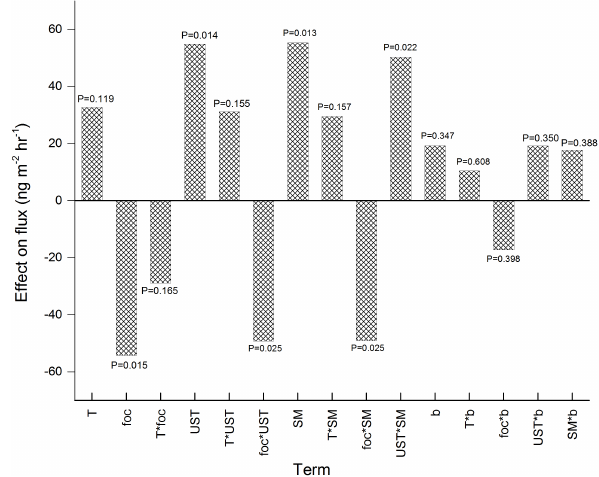
Figure 6. Sensitivity analysis based on the 2 5 factorial design for bare lands after prescreening model variables shown in Table 3 to isolate the significant factors. T denotes surface air temperature, foc denotes fraction of organic carbon in soil, UST denotes friction velocity, SM denotes soil mercury content, b denotes scaling factor for Hg reactivity ( β Hg0 ). "*" denotes interaction effects.